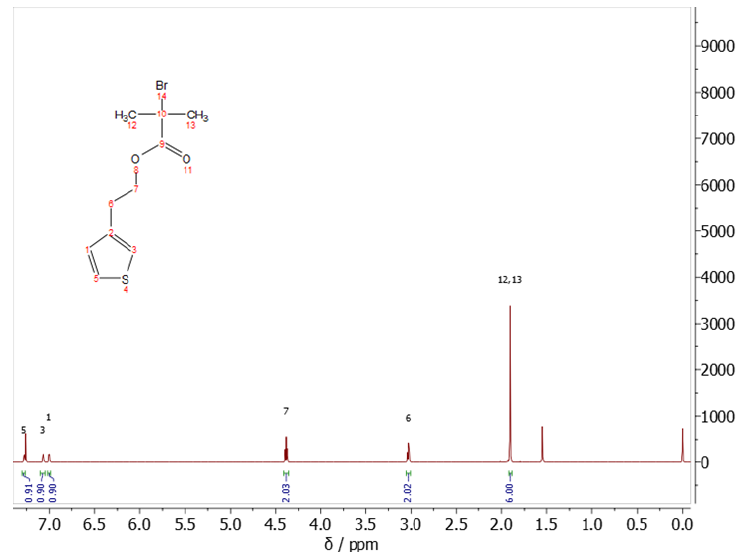
Figure 9. 1 H NMR spectrum of ThBr